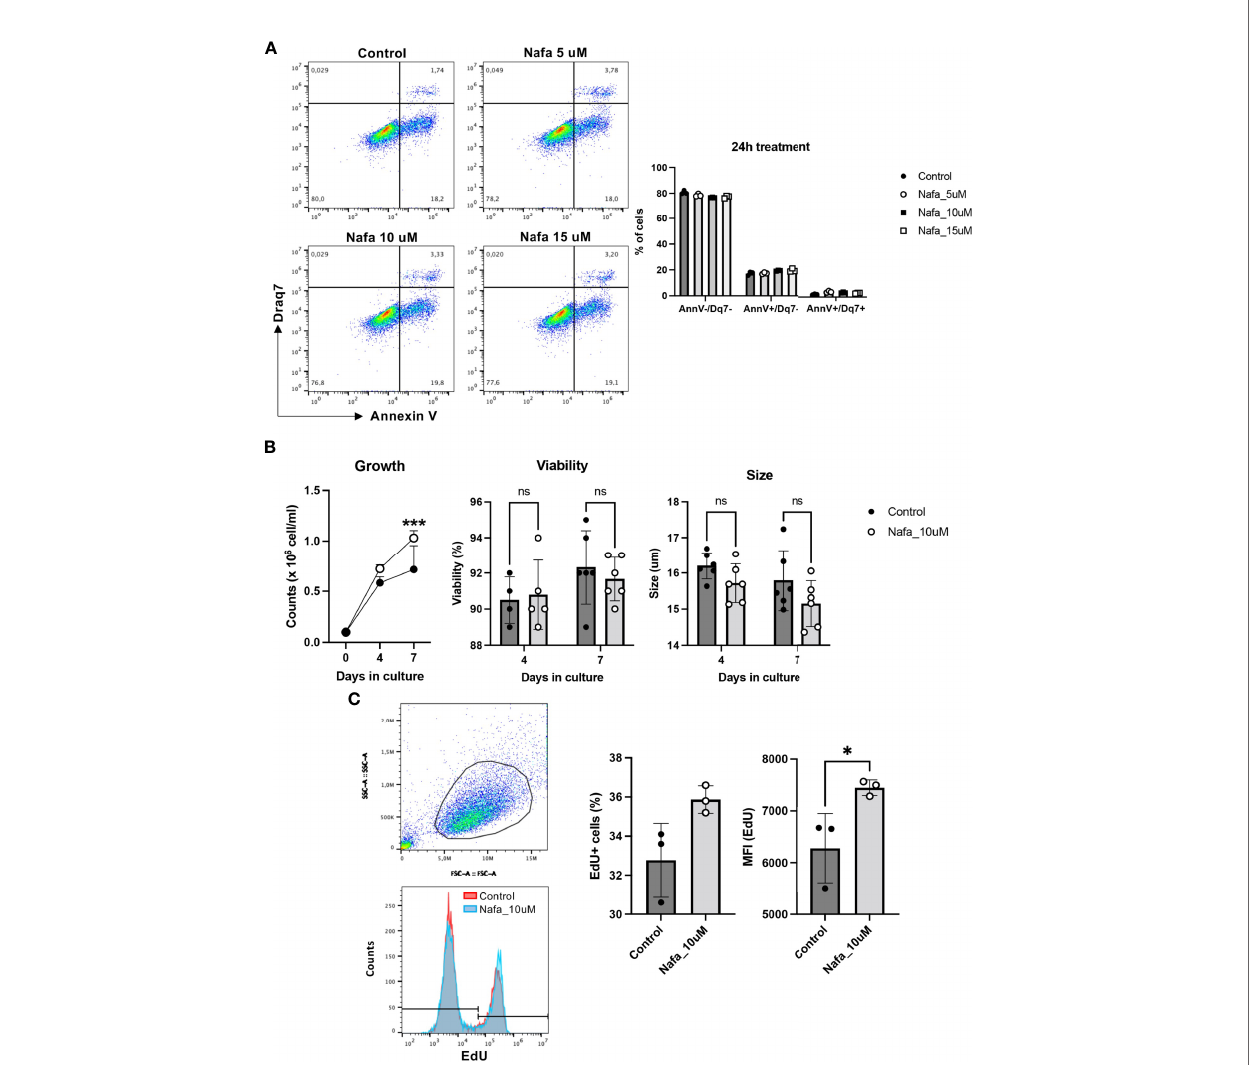
FIGURE 7 | Nafamostat increases proliferation of HMC-1 cells. HMC-1 (0.1 x 10 6 cell/ml) were left untreated or cultured in presence of nafamostat. (A) Flow cytometry analysis showing representative dot plots and cell viability of HMC-1 cells after 24h treatment with different concentrations of nafamostat; quanti fi cation is shown in the right panel. (B) Cell counts in control cultures and in cultures containing 10 m M nafamostat. Note the increase in cell numbers when cells are cultured in the presence of nafamostat. No effect of nafamostat was seen on cell viability as measured by trypan-blue staining or on cell size. (C) Cells were assessed for proliferation by EdU staining and fl ow cytometry analysis. Representative dot blot shows gated alive cells (upper left panel) and merged representative histograms for the EdU staining (left lower panel). Quanti fi cation of the EdU staining as % EdU + cells and mean fl uorescence intensity (MFI) is depicted in the right panel. Data are represented as mean values ± SEM and analyzed with 2-way ANOVA and unpaired t test. * p ≤ 0.05, *** p ≤ 0.0001. ns, not signi fi